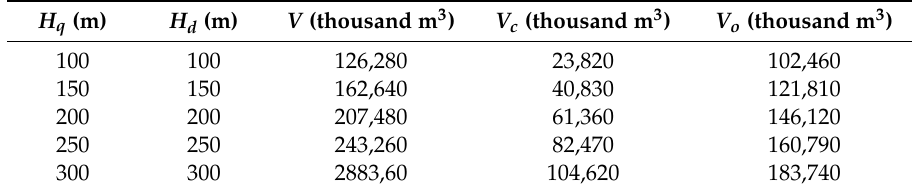
Figure 9. A family of diagrams of first-stage pit length L fqb (bottom) and L fqt (top) in accordance with strata dip angle a st . Table 2. The volume of the rock mass in the surface mine V , coal ( V c ) and overburden placed in internal dump V o , according to the pit depth H q and dump height H